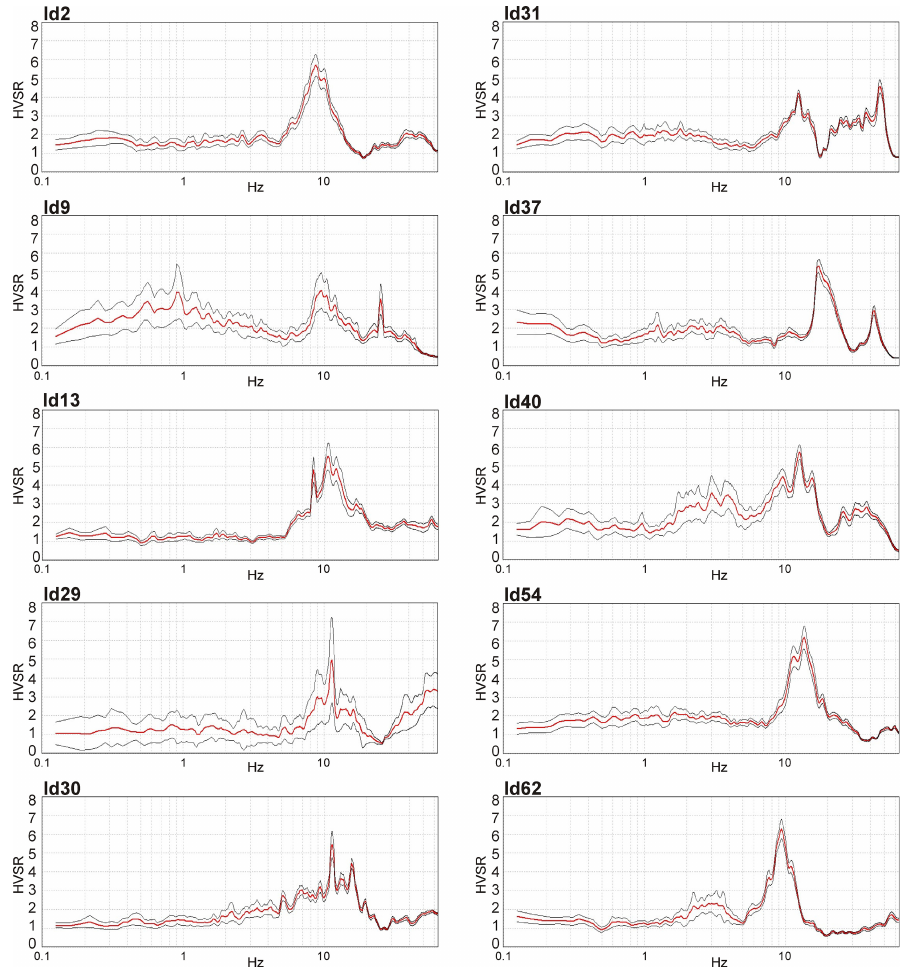
Figure 5. Examples of microtremor measurements on points where a clear HVSR response was obtained. Locations of measurements are shown in Fig. 2. Thin lines represent the 95% confidence